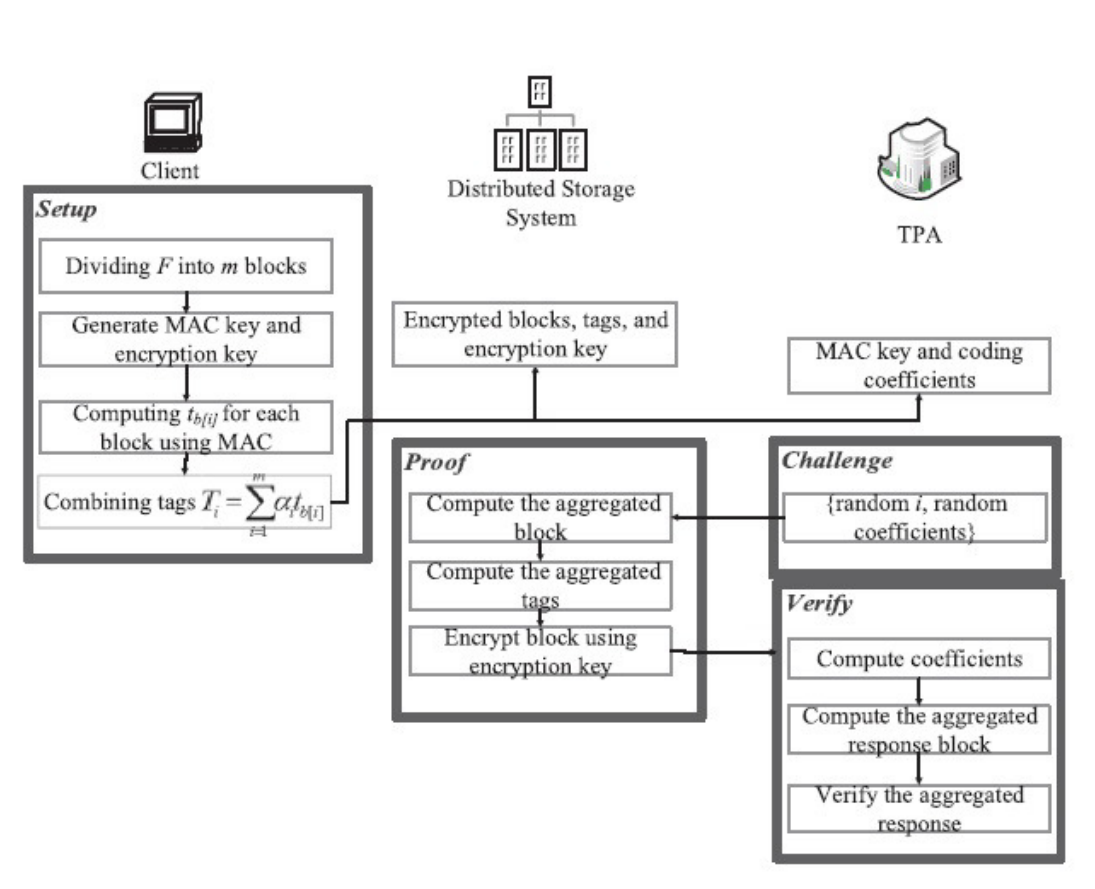
Fig. 8 Network Code Remote Data Auditing